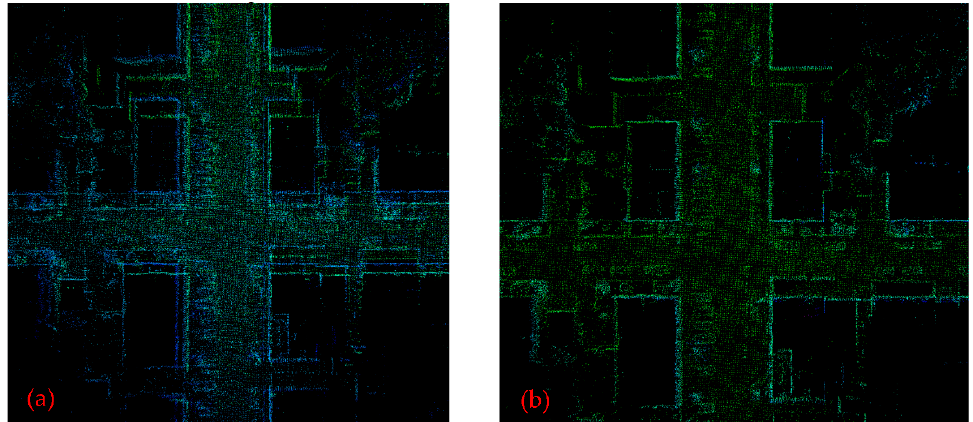
Figure 6. Partial enlarged view of the red box part of Figure 5. ( a ) By LeGO-LOAM; ( b ) by LeGO- LOAM-SC.